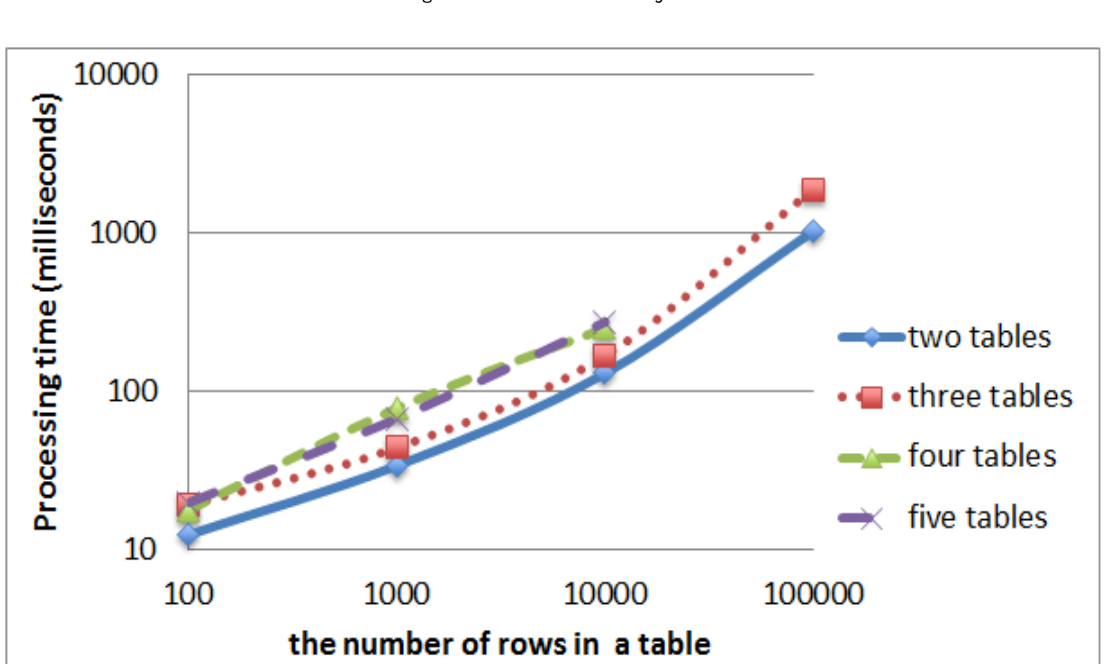
Fig. 9. Time of multi-table join.